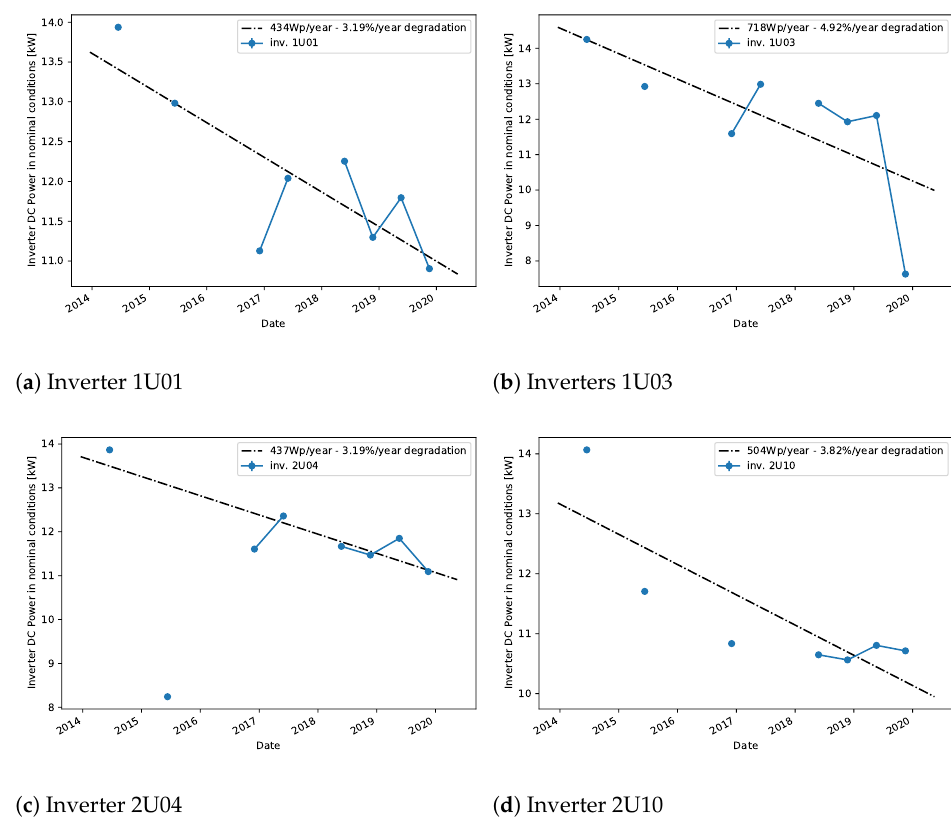
Figure 7. Predicted NOCT power for selected inverters of plant